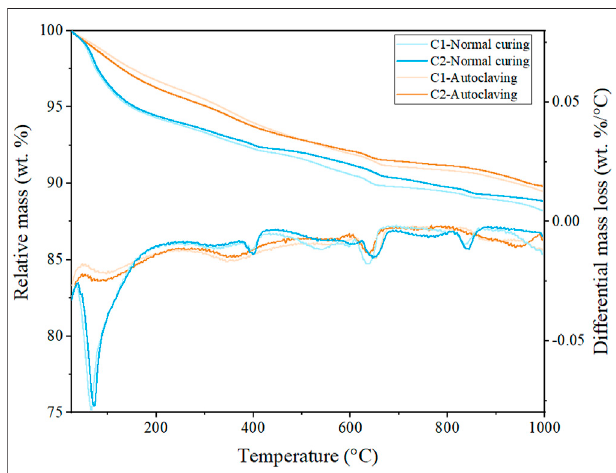
FIGURE 4 | TG and DTG diagrams of the samples after different